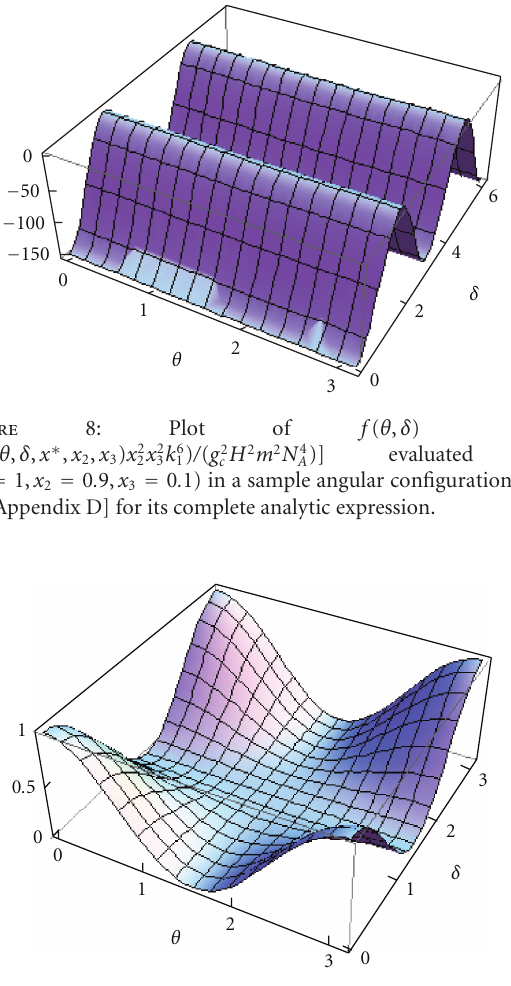
Figure 9: Plot of the anisotropic part of the trispectrum from the contribution due to vector-exchange diagrams in a sample angular configuration. See [100, Section 8] for its analytic